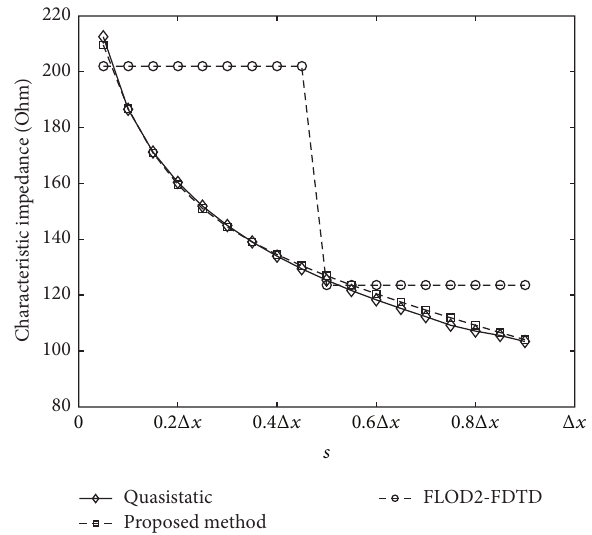
Figure 4: Calculated results of the proposed method and the FLOD2-FDTD with the same grid size and CFLN.